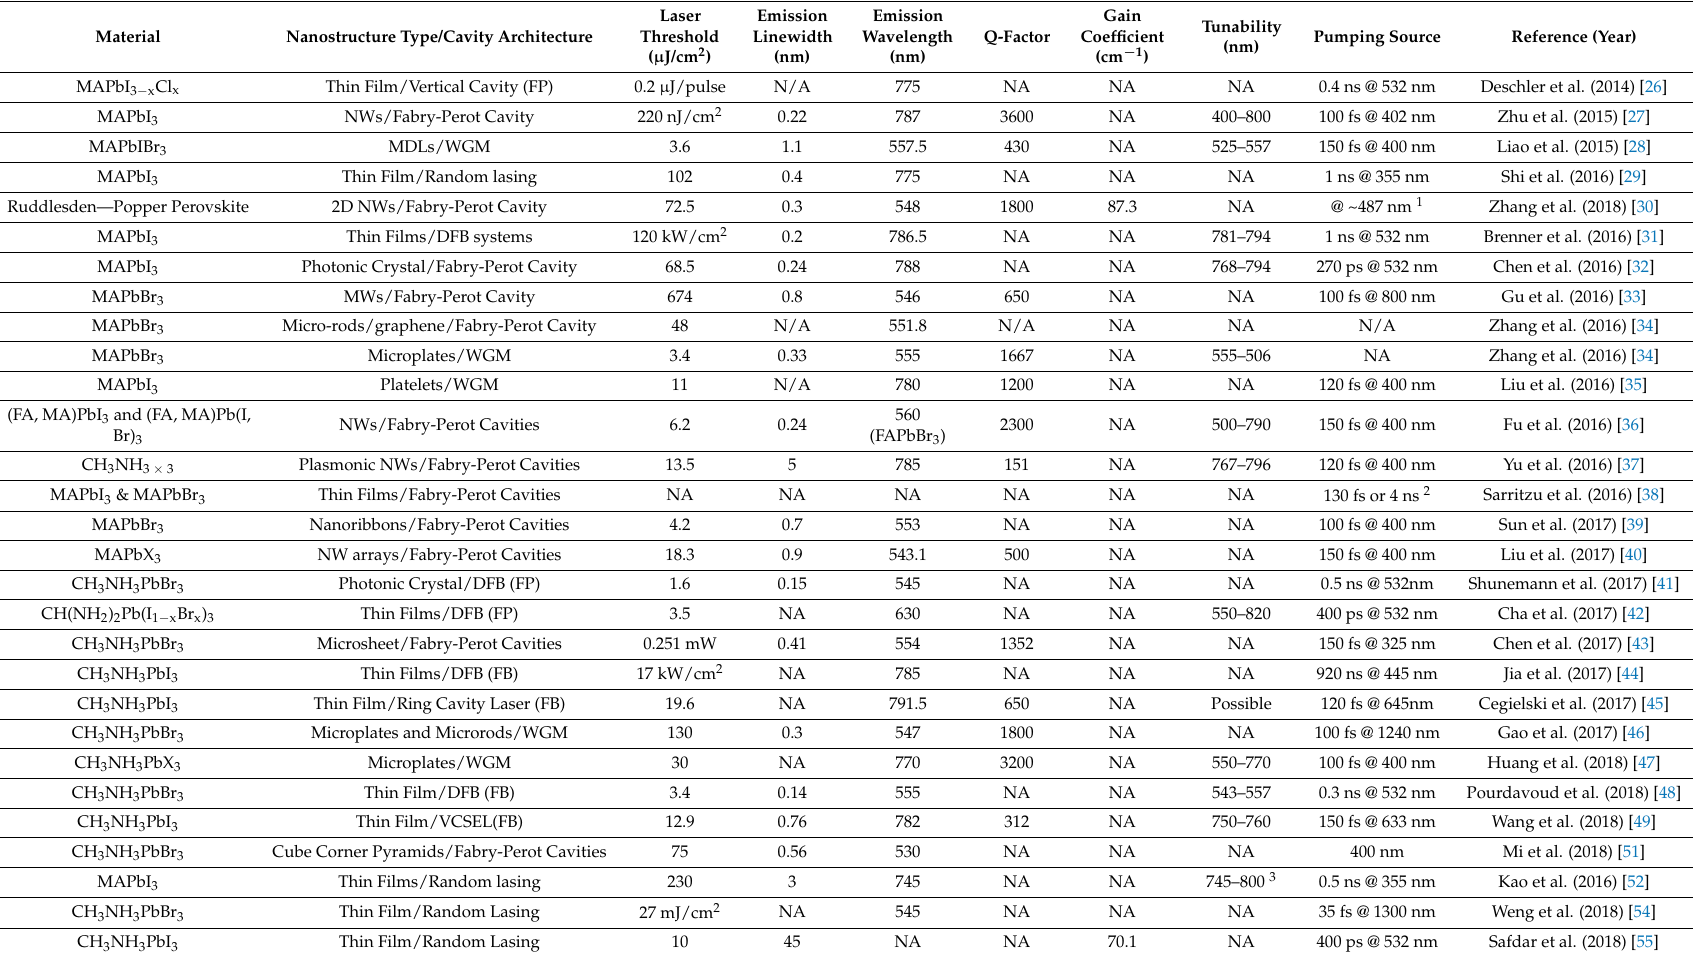
Table 1. Organic-Inorganic Perovskite Based Laser Device Characteristics; NA denotes for the Non-Available Information. Material